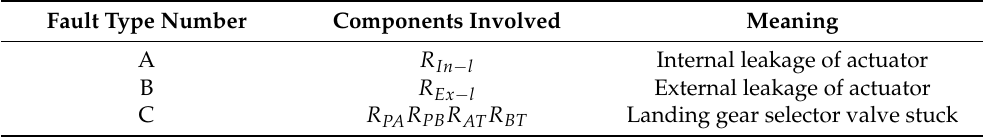
Table 3. Fault type and corresponding parameters. Fault Type